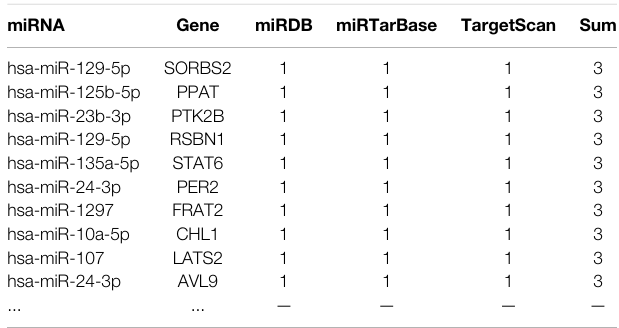
TABLE 3 | MiRNA target gene prediction. miRNA Gene miRDB miRTarBase TargetScan